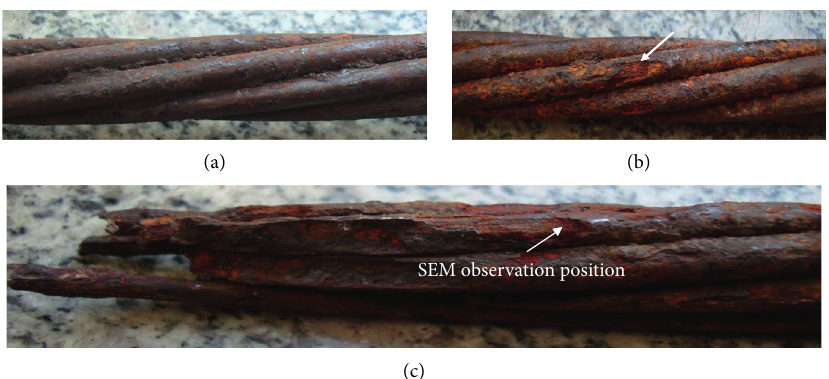
Figure 7: Macrofracture corrosion morphology of the anchor cable: (a) the steel strand near the anchorage; (b) the steel strand near the anchorage, about 900mm away from the anchorage; (c) fracture position.